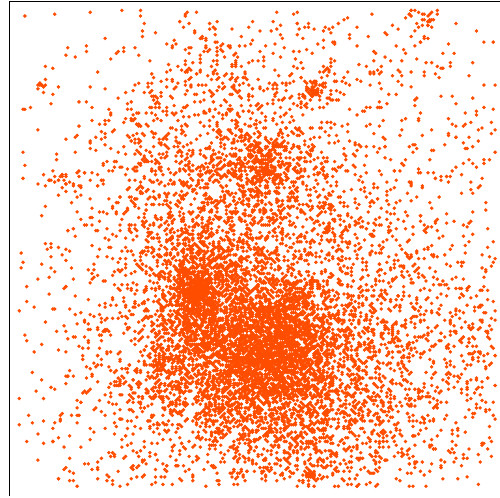
Figure 4. Zooming in on the largest halo: 4 × 4 pixels at position (0 . 74 , 0 . 31) in Figure